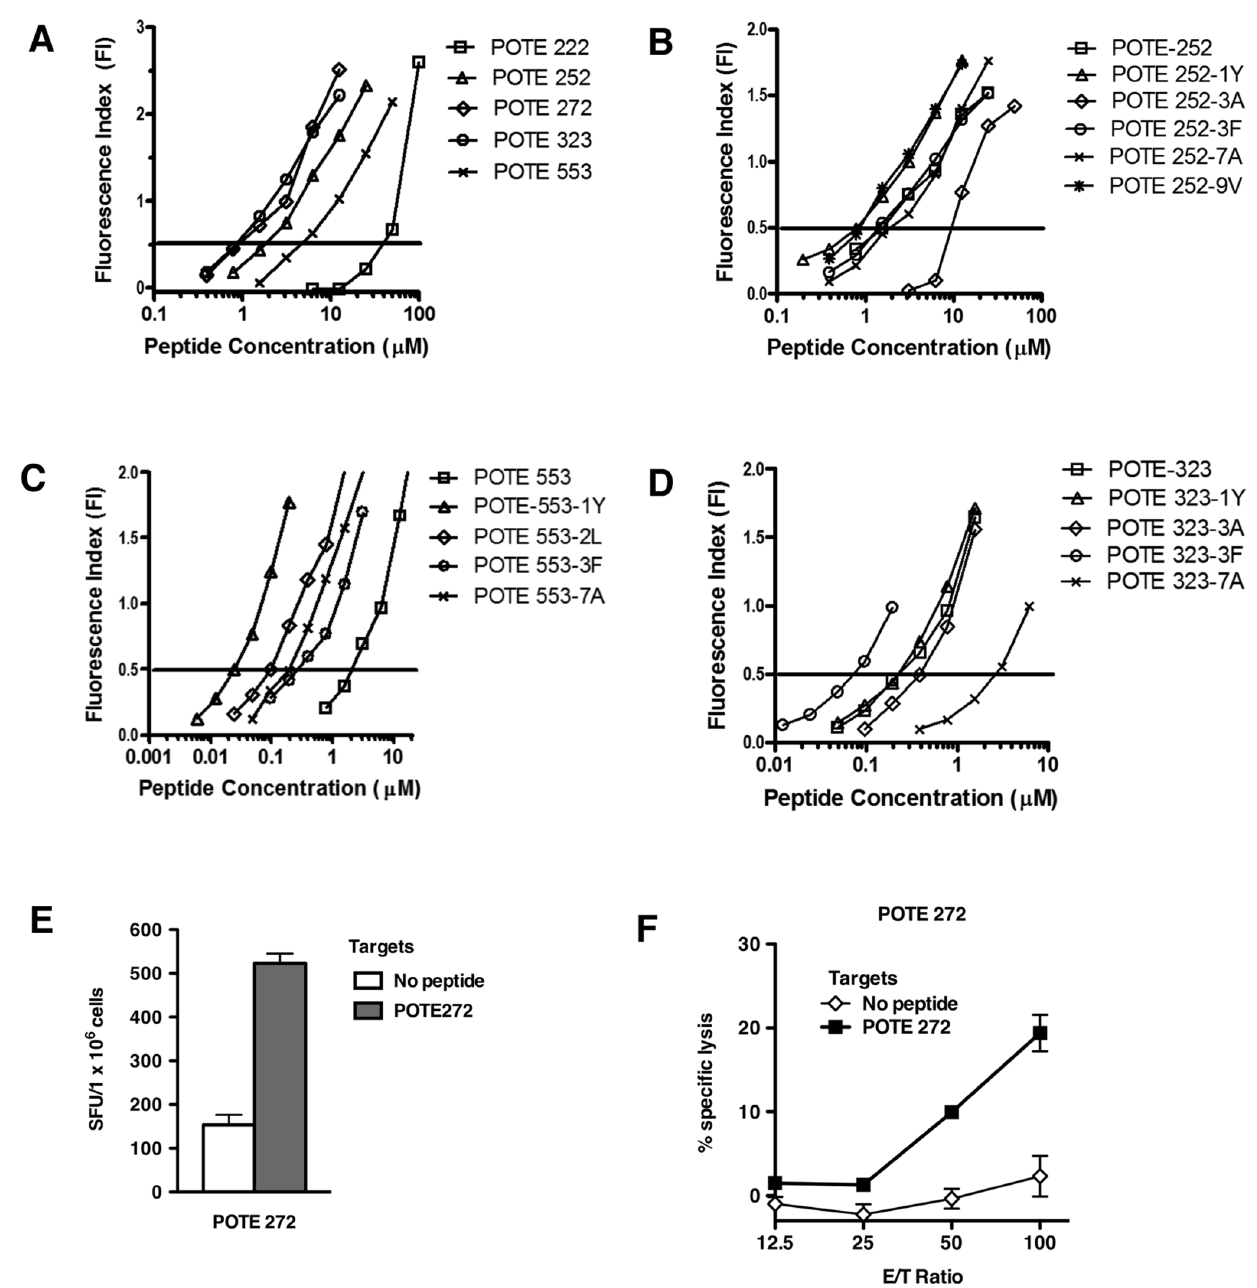
Figure 1. T2 binding assays and immunogenicity study. (A). The HLA-A2 binding affinity of the 5 predicted POTE epitopes was confirmed by T2 binding assay. The calculated FI 0.5 for POTE 222, 252, 272, 323 and 553 were approximately 42.4 m M, 1.6 m M, 0.9 m M, 0.8 m M and 5.6 m M, respectively. Binding affinity of the substituted POTE 252 peptides (B), the substituted POTE 553 peptides (C) or the substituted POTE 323 peptides (D) to HLA-A2 molecules. Each assay was performed in triplicate, and data in this figure are representative of two experiments with similar results. Immunogenicity of the POTE 272 epitope in AAD mice (E). Mice were immunized with 50 nmol of POTE 272 in 100 m l of emulsion, and targets were pulsed with 1.0 m M POTE272. Spots were counted by an ELISPOT reader (AID ELISPOT reader system). Figures show numbers of spots per million cells. (F) CTL reactivity on POTE 272 peptide. In a 4 hour 51 Cr release assay, CIR.AAD cells were pulsed with 1.0 m M POTE 272 peptide and labeled with 51 Cr. After washing three times, target cells were mixed with different numbers of effector cells and then cultured for 4 hours before